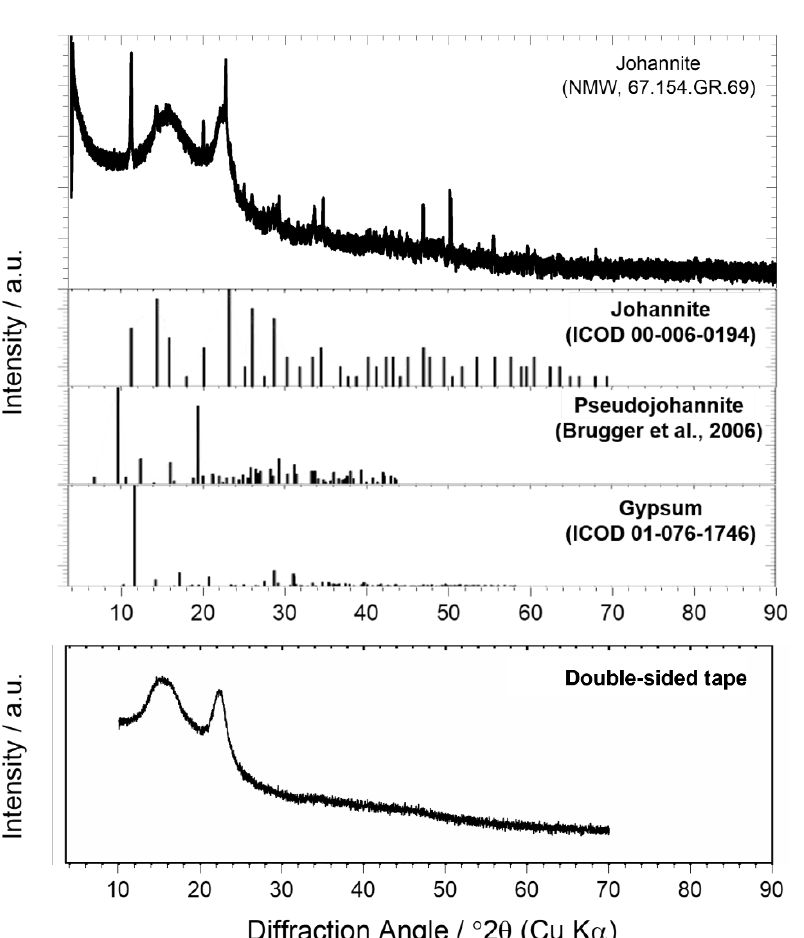
Figure 4. The XRD pattern of johannite sample NMW 67.154GR.69 with the peaks labelled with the lattice spacings (in Å). Reference XRD patterns for johannite, pseudojohannite, and gypsum (minor species) from the HighScore database (PANalytical HighScore Plus version 3.0) and Brugger et al. [3] are shown underneath for comparison (top panel) and a “background” XRD pattern of the double-sided tape used to secure the crystal fragments in place (bottom panel). Intensity is given in arbitrary units (a.u.).